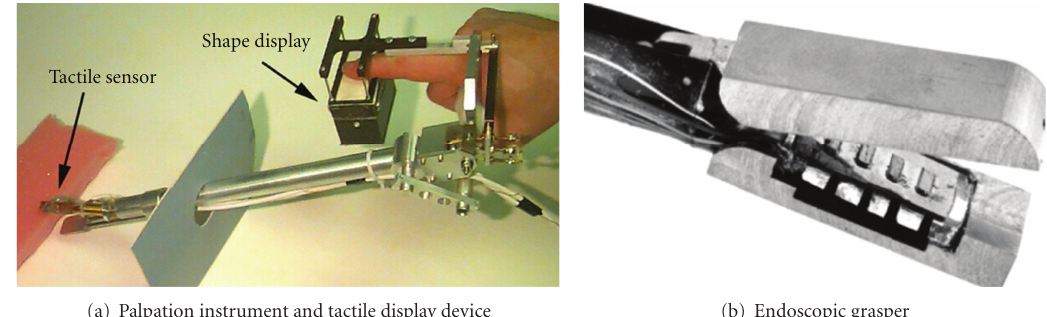
Figure 5: (a) A remote palpation and display device developed by Harvard for MIS. Tactile information of the palpated tissue is transmitted from the organ tissue via the endoscopic device to the surgeon’s fingertips during MIS [11]. (b) Tactile sensor array made of PVDF piezoelectric films at Concordia University is integrated in the jaws of an endoscopic grasper to measure tissue sti ff ness characteristics